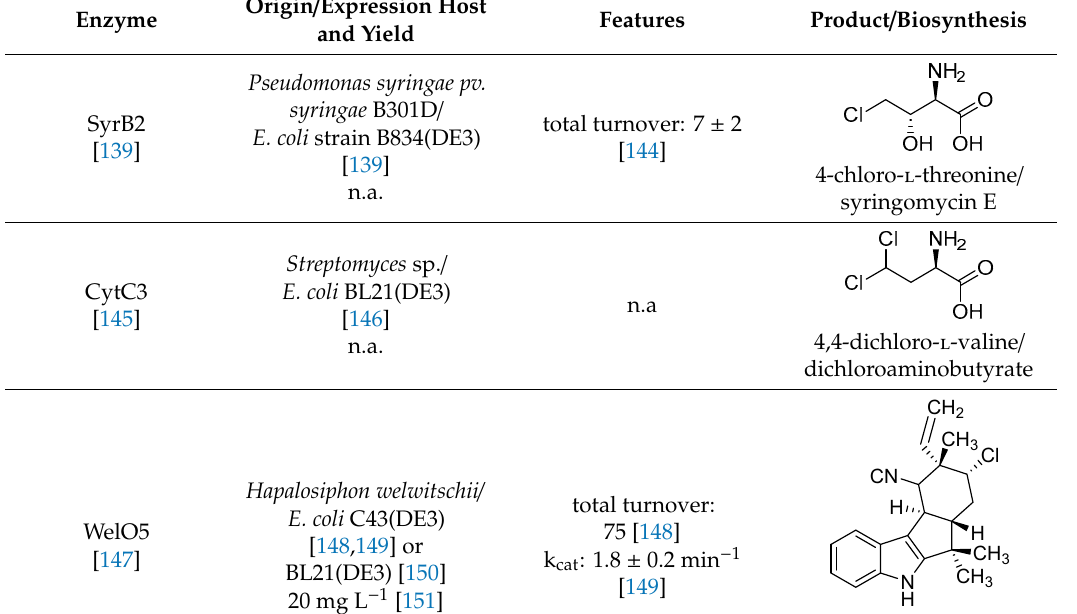
Streptomyces sp.